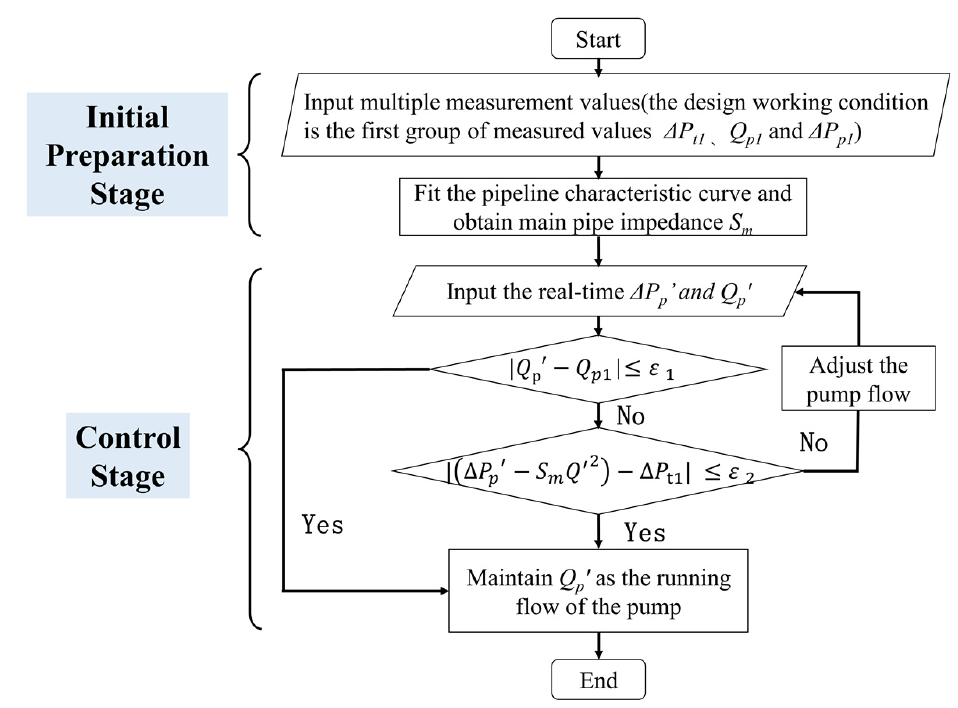
Figure 5. Control logic diagram.